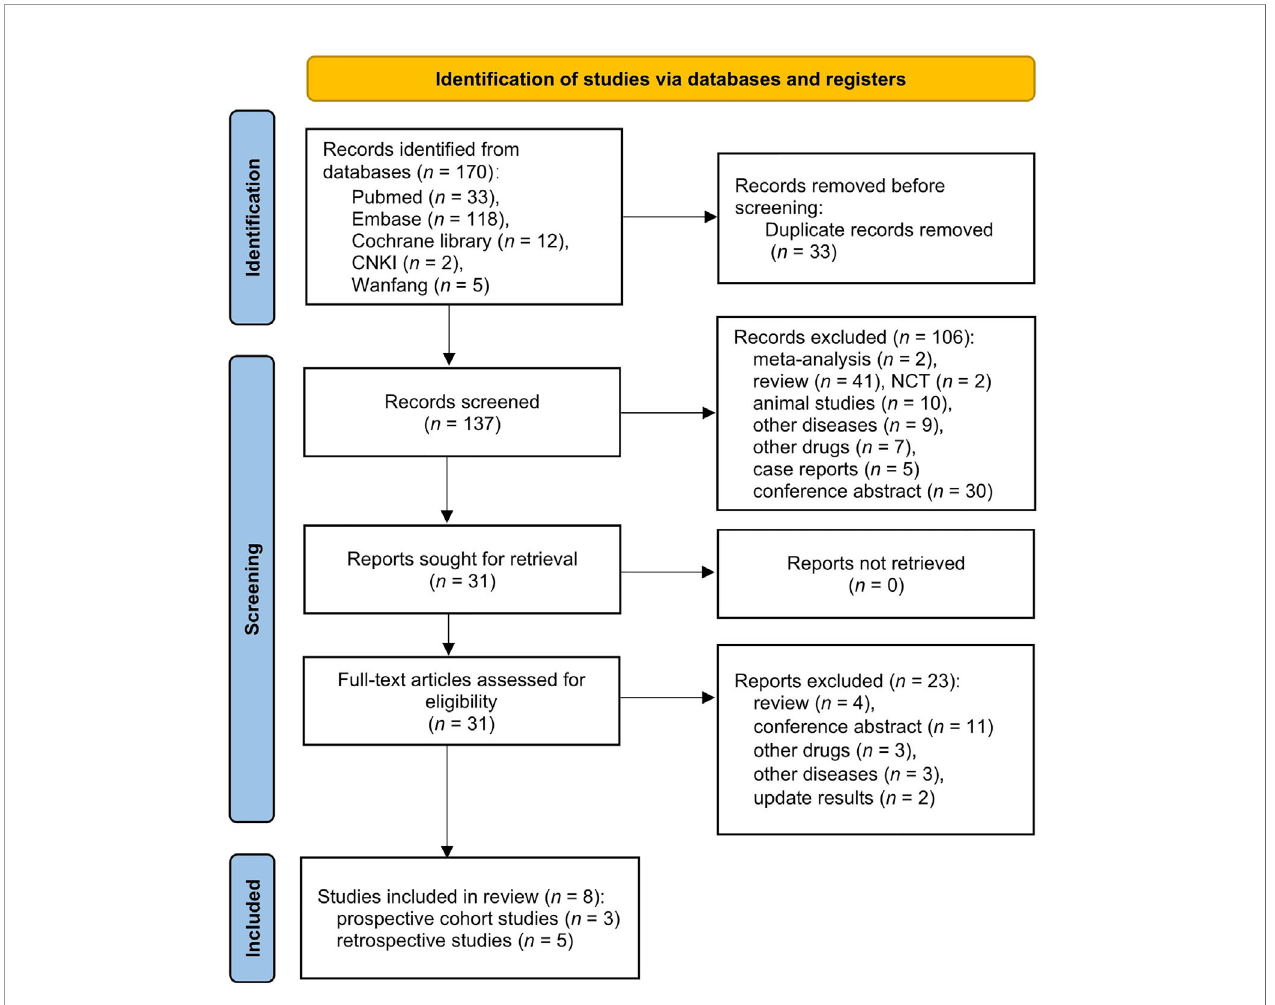
FIGURE 1 | Flow diagram of study